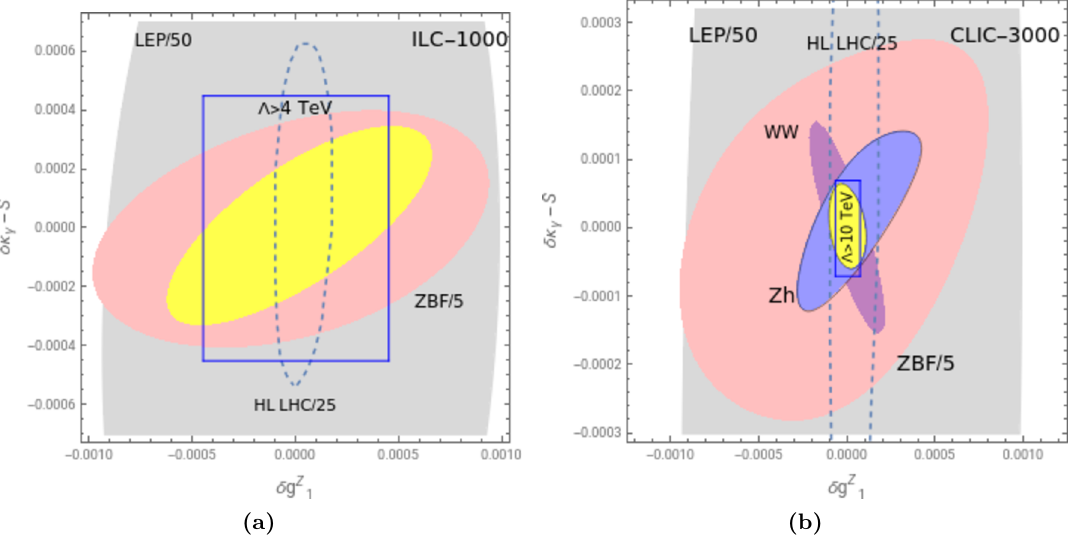
Figure 6. (a) Projected sensitivities for the case of universal new physics for ILC 1000 and their comparison with LEP bounds [82] and HL-LHC projections [38] (b) Projected sensitivities for the case of universal new physics for CLIC 3000 and their comparison with LEP bounds and HL-LHC projections. We have assumed W = Y = 0 . See the text for more